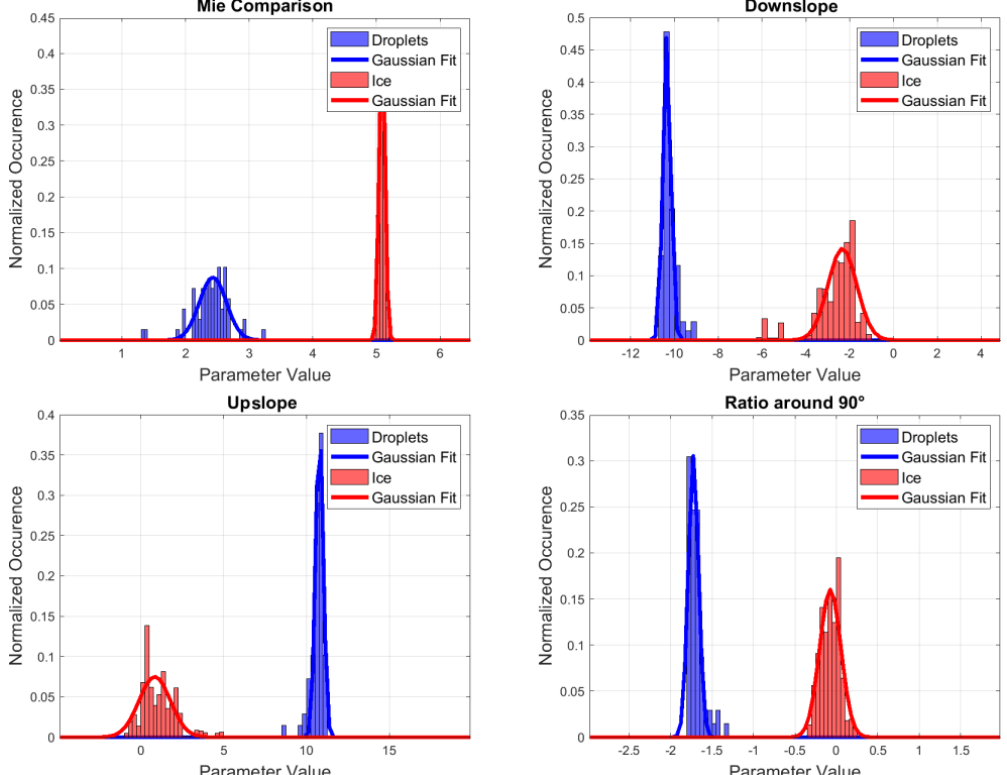
Figure 5. Normalized histograms of the discrimination features f i evaluated for theoretical ASFs. Simulated ASFs were calculated using the Mie theory in the case of droplets (blue) and by selecting typical ice particle habits (red) from the light-scattering databases by Baum et al. (2011) and Yang et al. (2013). Normal distribution fits to the data are depicted by solid lines in the graphs. Note that the simulations provide orientation-averaged ASFs, whereas the observed particles by PHIPS have random but fixed